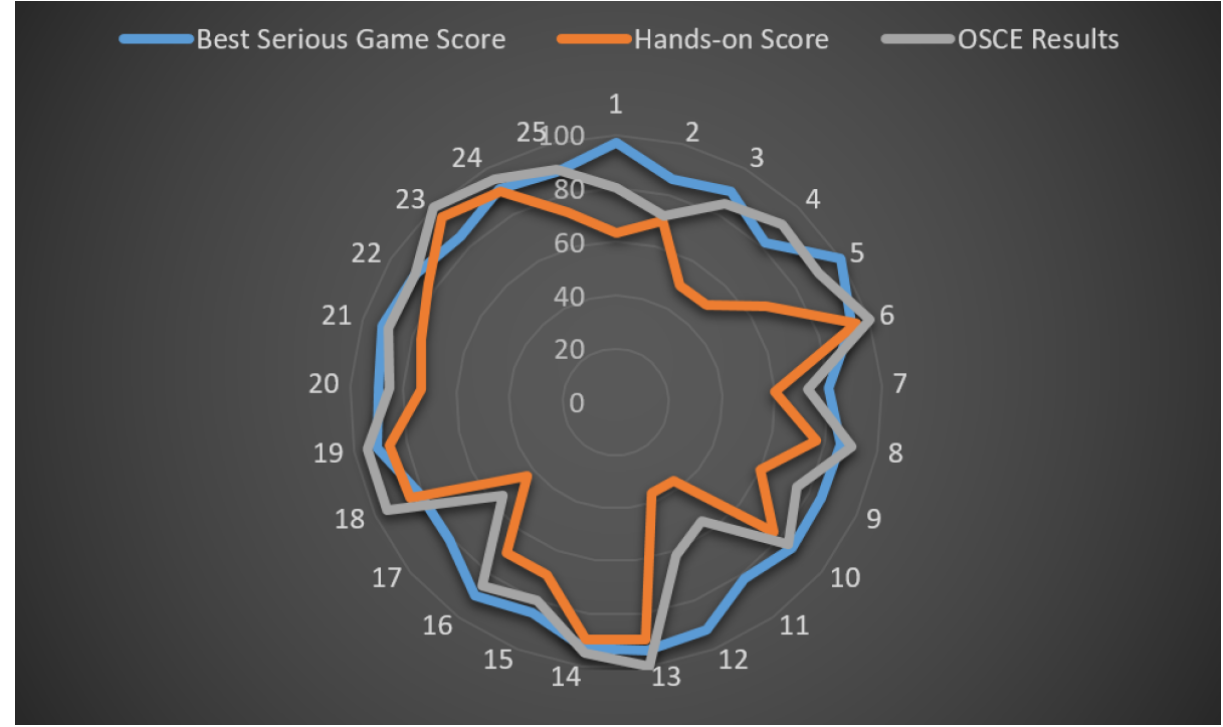
Figure 10. Serious game, hands-on training app and OSCE scores of 25